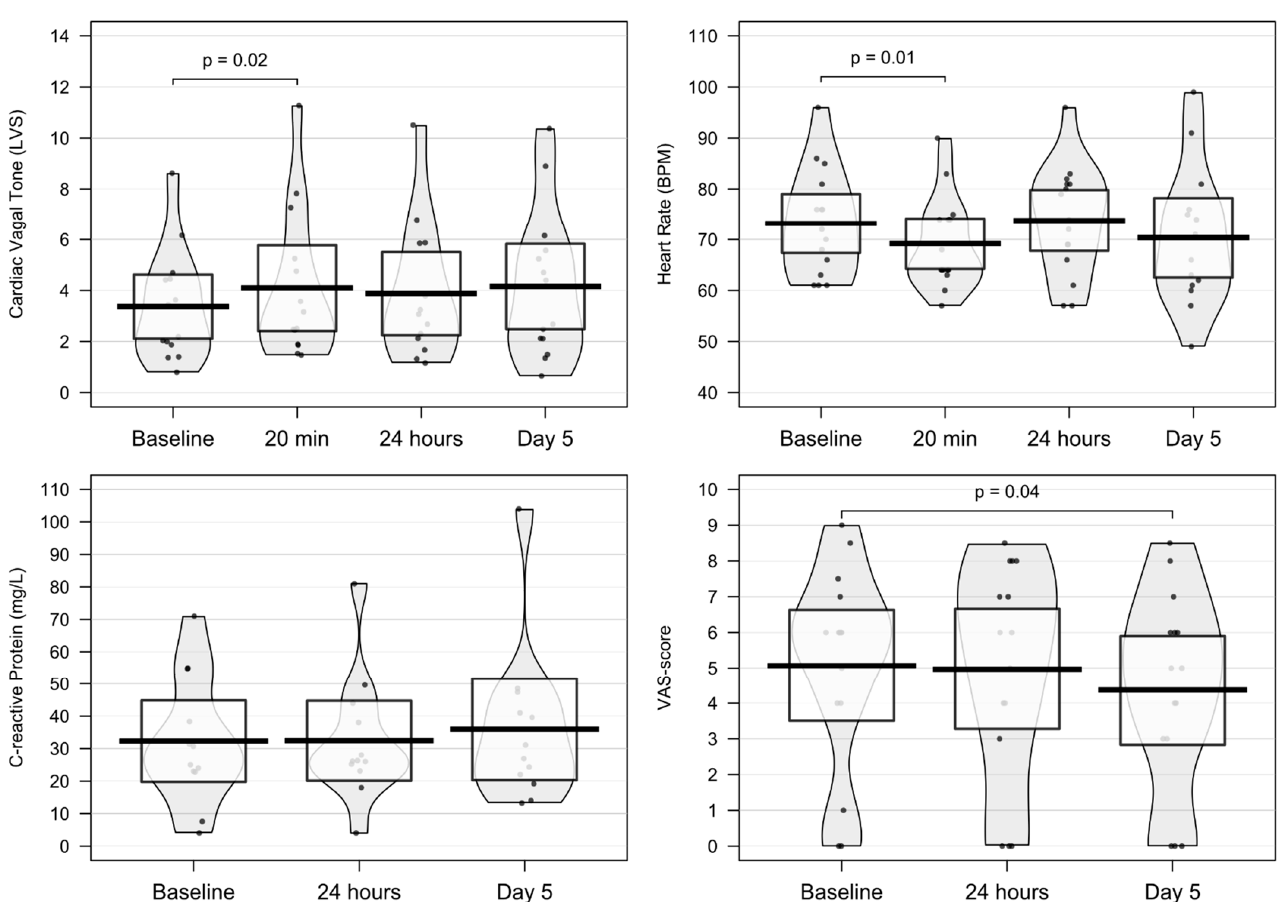
Figure 1. Raw data points, mean, and 95% CI of selected outcomes.